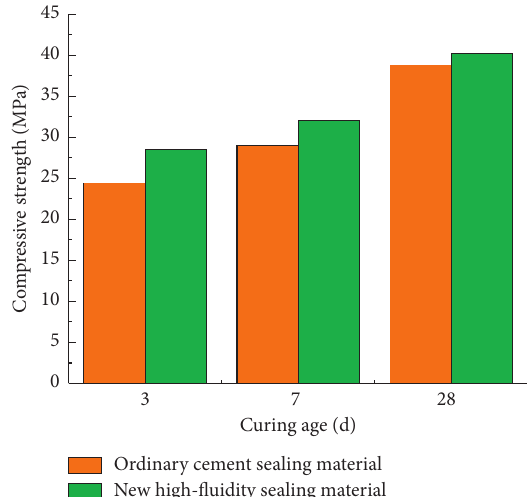
Figure 12: Changes in compressive strength of new high-fluidity materials and ordinary cement materials.